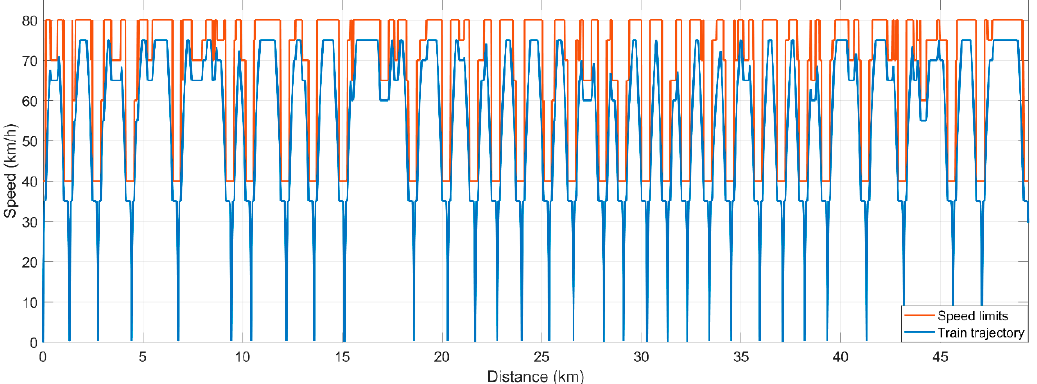
Figure 9. Train operation (up-direction with the station speed limit at 40 km / h).